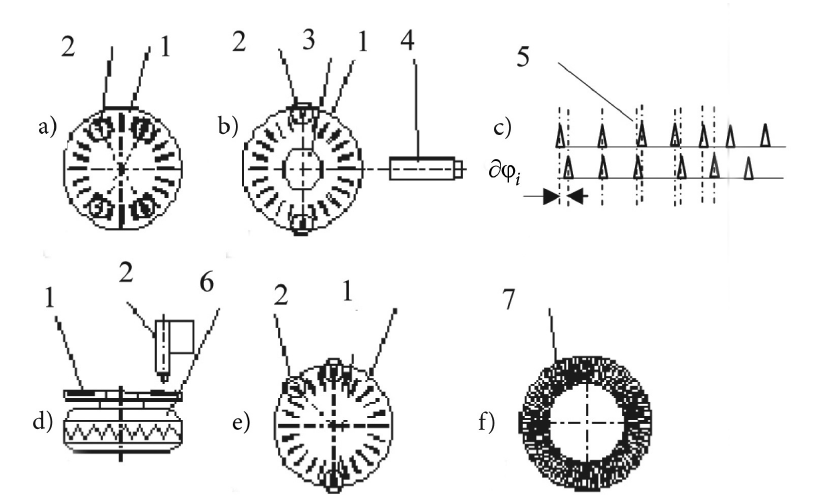
Fig. 2. Methods for circular scale measurement: a) constant angle placement and using 4 microscopes in the circle; b) calibration using a prism, autocollimator and 2 microscopes; c) rotating and comparing transmitted signals from the measured scale and reference measure; d) calibration while comparing strokes with precise Moore Indexing table standard; e) calibration using three microscopes and half circle etalon; f) the method of a moire fringe